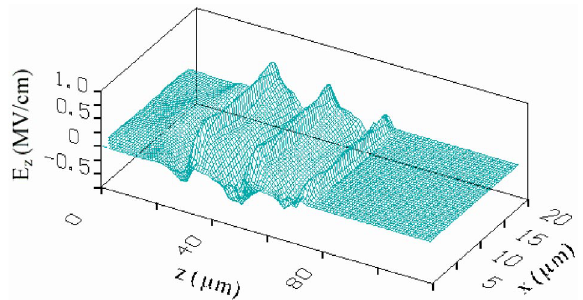
excited by the z FIG. 9. Dependence of axial field E x (cid:3) 0 and y (cid:3) 0 for Fig. 7. The electric field at the third bunch position is considerably stronger than at the second